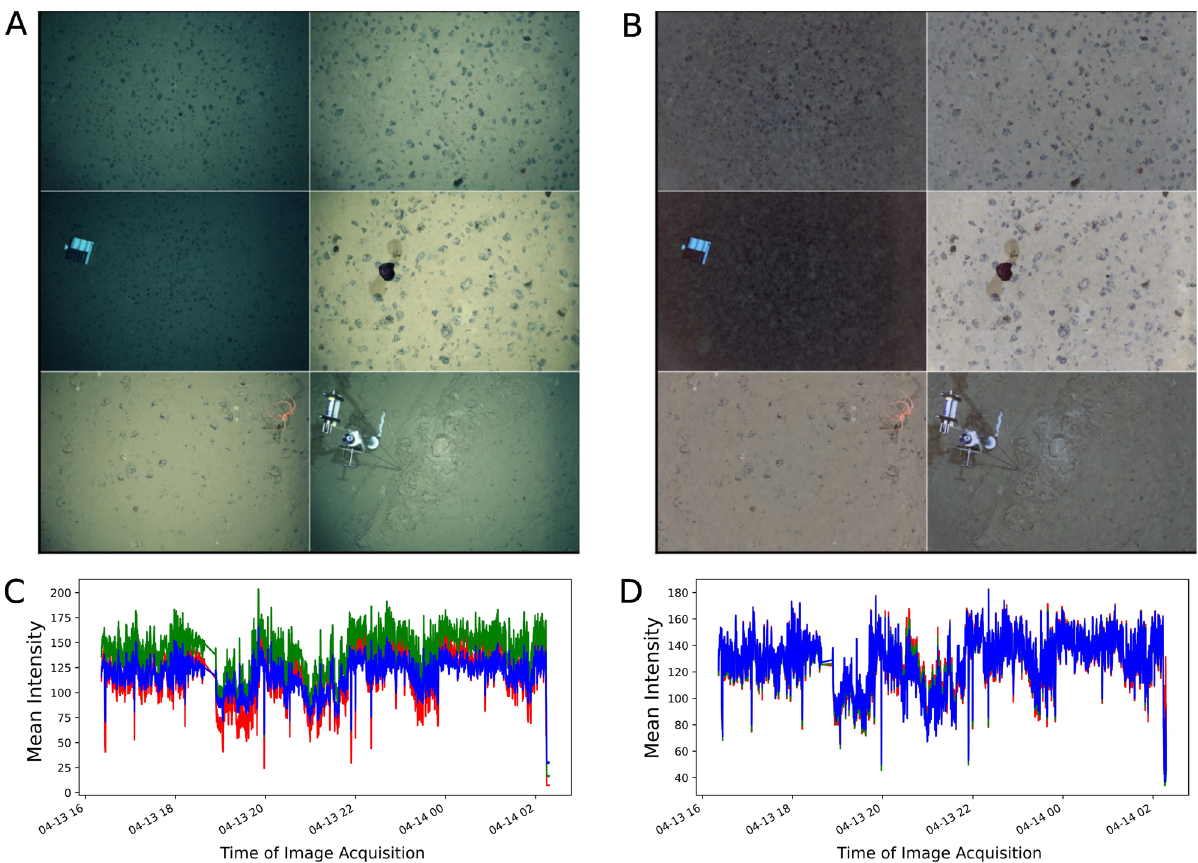
Figure 2. Comparison between sets of ( A ) original images and ( B ) images corrected for illumination drop-off. ( C ) Mean intensity plots calculated for each R, G, B channel in original images and, ( D ) corrected images from OFOS dive 126. Note the altered scale on the y axis between ( C ) and ( D